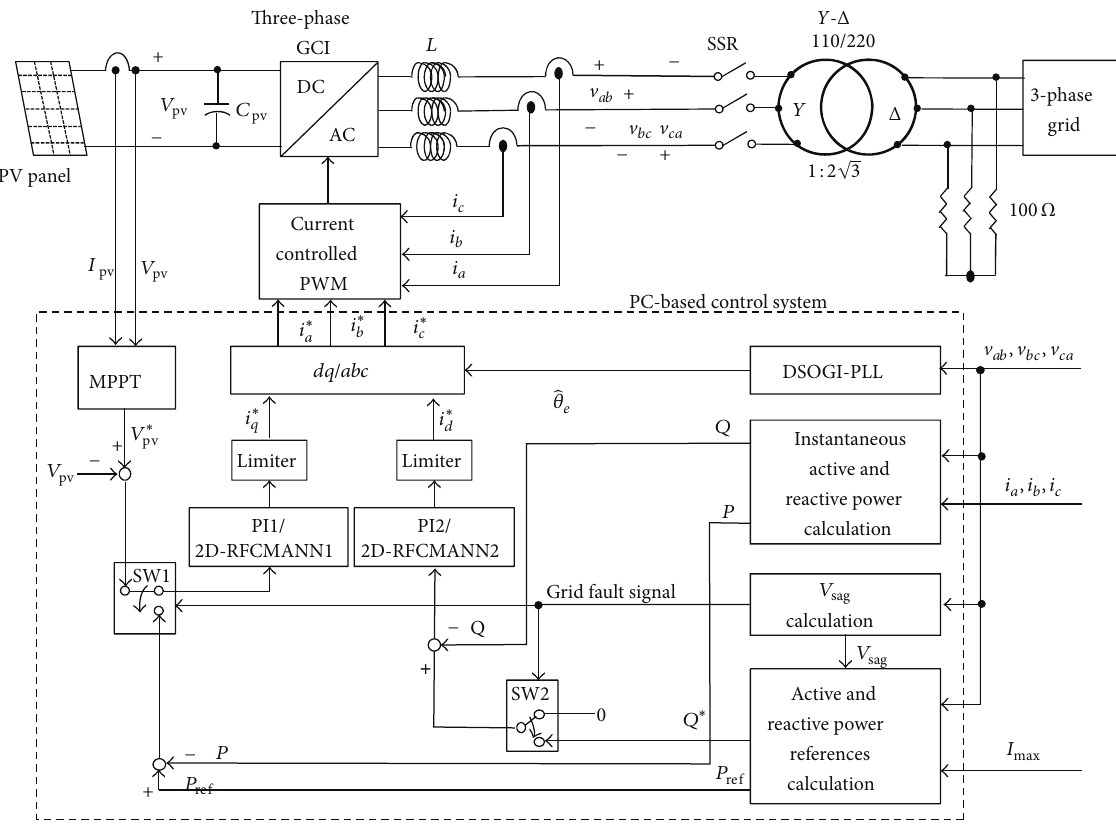
Figure 4: Schematic diagram of PC-based control